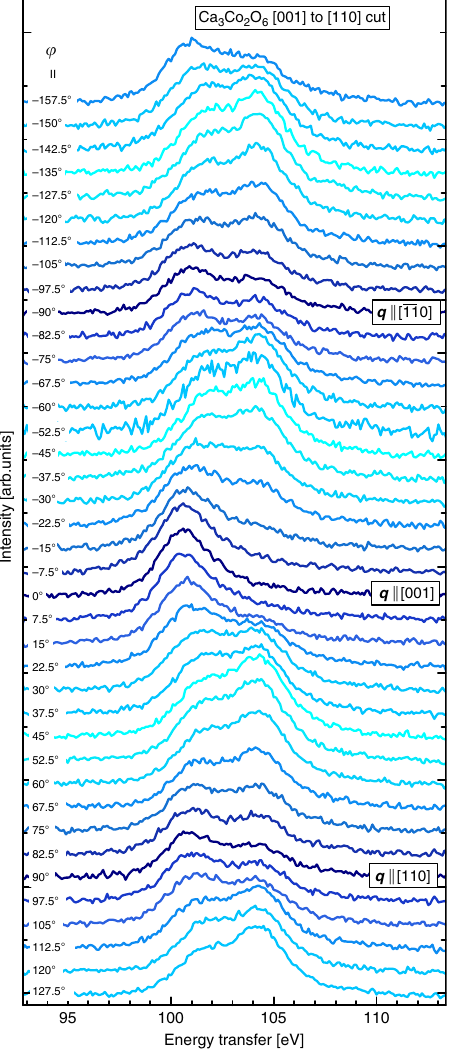
Fig. 3 NIXS spectra at the Co M 1 edge. An array of spectra were recorded by rotating the sample in 7.5° increments such that q remained in the [110] to [001] crystallographic plane. The integrated intensity of the peaks is directly proportional to the hole density of the Co d -electrons in the direction of the momentum transfer q . The color coding is such that the darkest blue curves are spectra taken with q parallel to high symmetry directions of the single crystal Ca 3 Co 2 O 6 . Voigt functions to model the 1.4 eV FWHM Gaussian experi- mental energy broadening, and the lifetime broadening, for which a 1.8 eV FWHM Lorentzian provides the optimal fi t. When implementing the fi tting procedure across the array of spectra of Fig. 3, the Gaussian and Lorentzian widths of the Voigt functions were fi xed, as well as the peaks ’ central energy positions throughout; only the intensities were free to vary to obtain the best fi t to the experimental spectra.